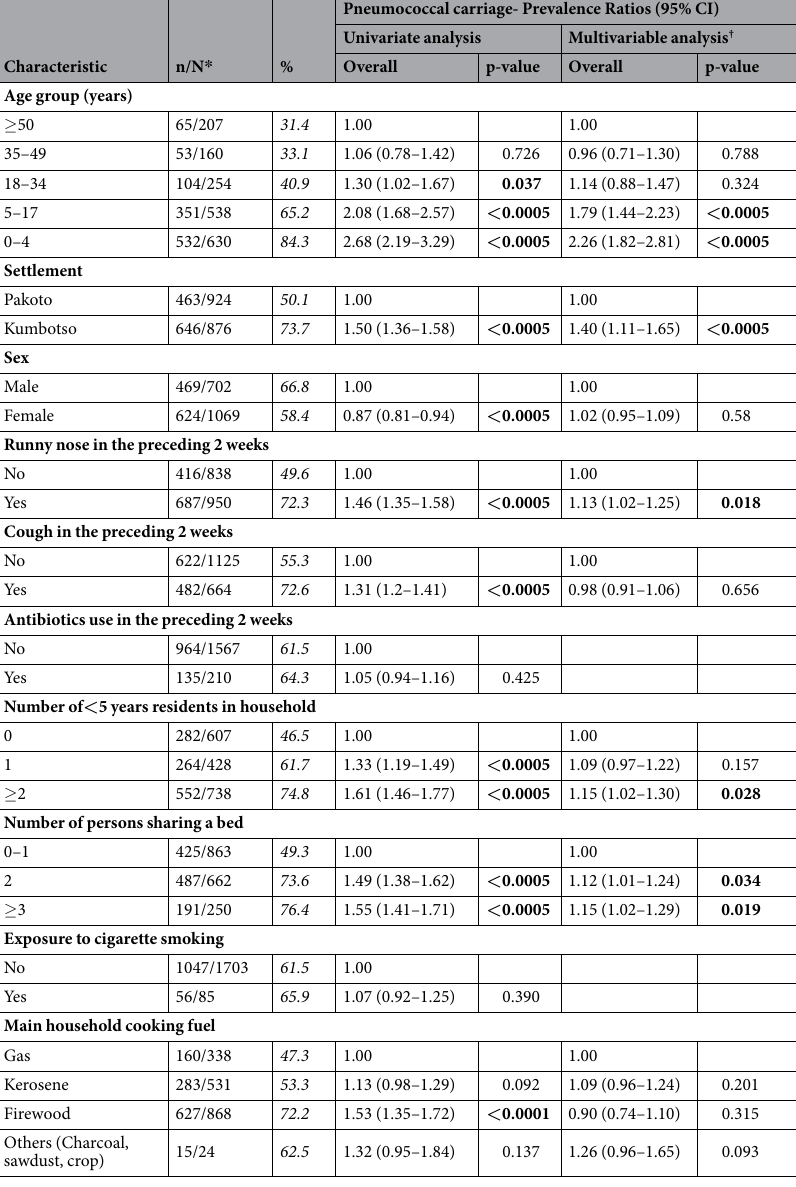
Table 4. Risk factors for pneumococcal carriage across all ages in Nigerian populations. † Results of a Poisson model with robust 95% CI are presented. * N may differ from total sample size 1800 because of missing